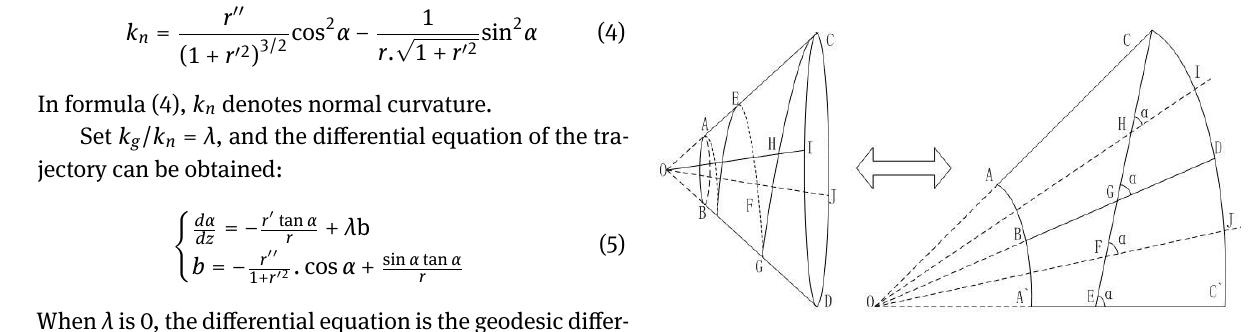
Figure 4: The sketch of the cone of the head of gasbag